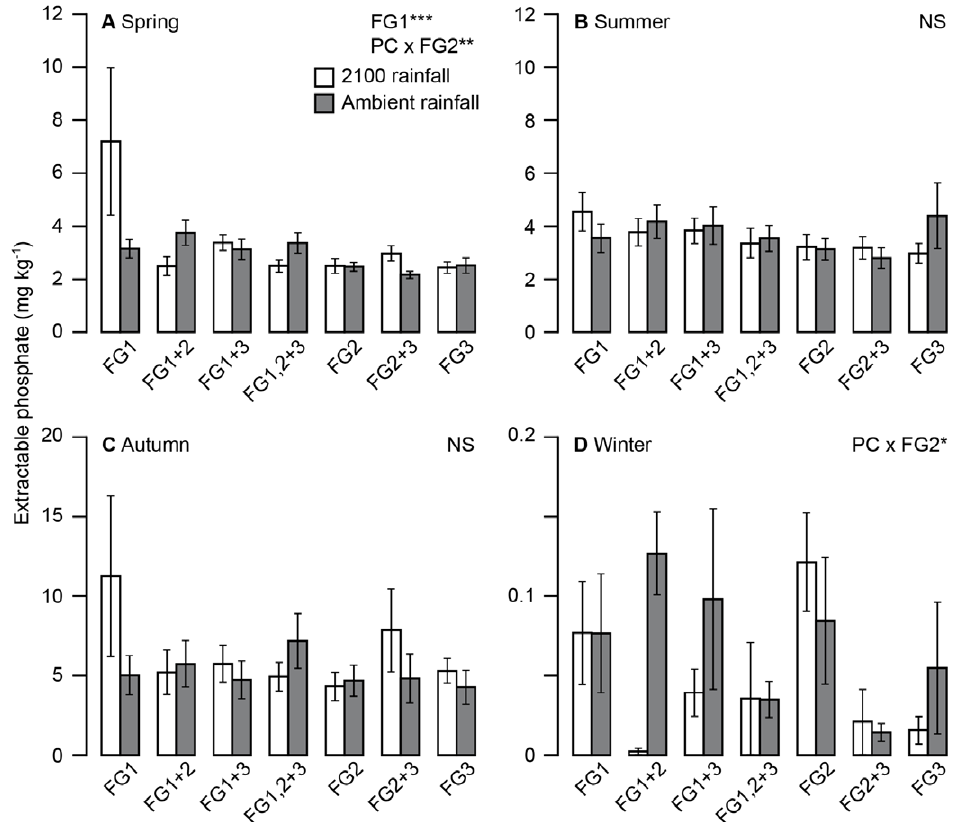
Figure 5. Effect of precipitation change and functional identity on extractable soil P in different seasons. The response of soil extractable P to precipitation change (PC) and functional group (FG) identity in each season. a) Spring (presence/absence of FG1, F 1,154 =14.1, p=0.0003, interaction between PC and FG2, F 1,45 =6.88, p=0.0096), b) Summer (NS), c) Autumn (NS), d) Winter (interaction between PC and FG2 F 1,45 =5.005, p=0.0303).